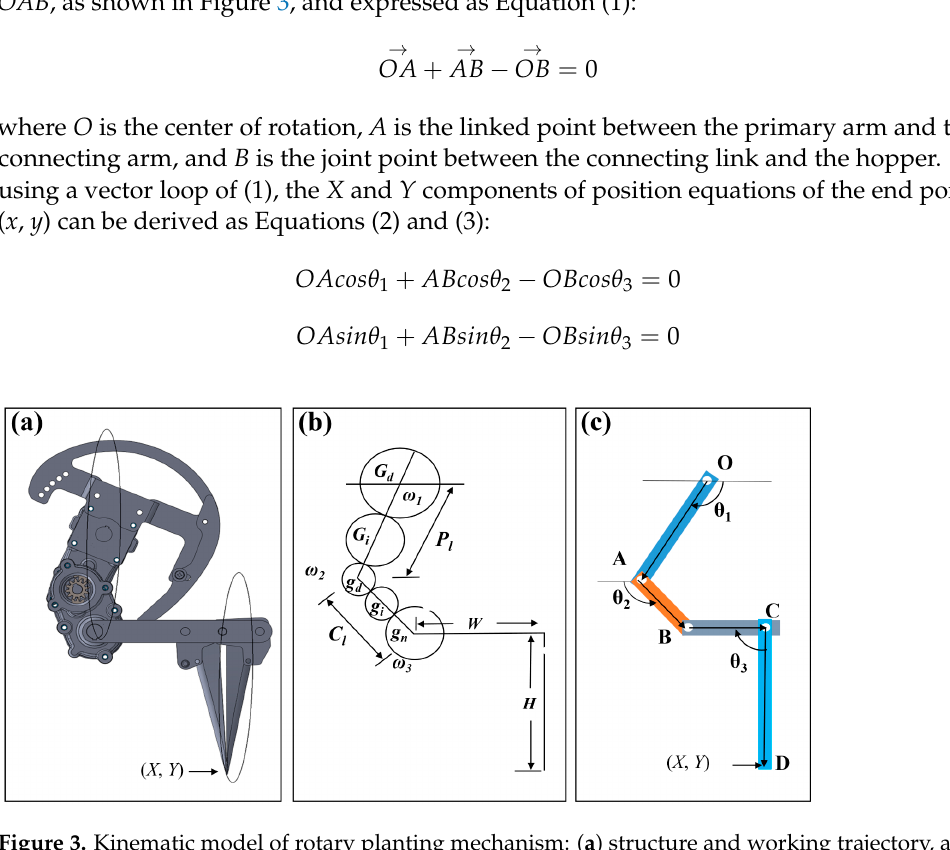
Figure 3. Kinematic model of rotary planting mechanism: ( a ) structure and working trajectory, and ( b , c ) kinematic representation of the planting mechanism.